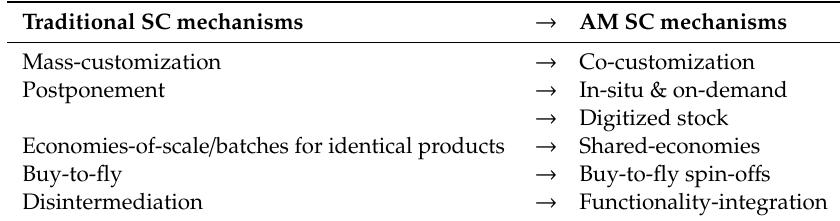
Table 4. Traditional SC vs. AM SC